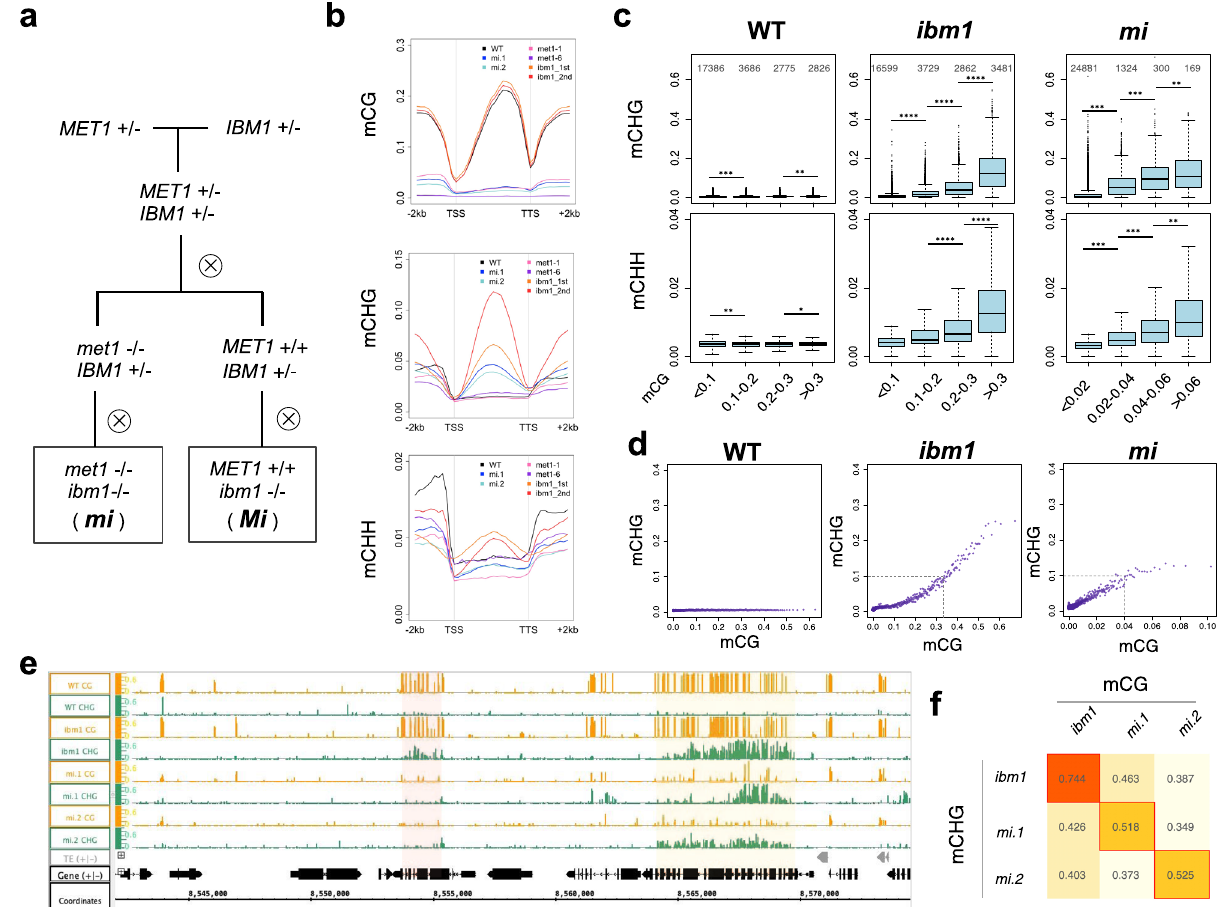
Fig. 3 Genic mCH is directed to regions with relatively high levels of mCG. a Materials used. Starting from the cross between plants having met1-1 ( met1 ) or ibm1-4 ( ibm1 ) mutation in the heterozygous state, the double heterozygote was self-pollinated to fi x met1 homozygote and MET1 wild-type in the F2 generation. The ibm1 mutation was fi xed to be homozygous in the F3 generation. The F3 plants with homozygous met1-1 mutation ( mi ) and homozygous wild-type MET1 ( Mi ) were used in this study. b Averaged mCG, mCHG, and mCHH pro fi les over genes in a WT plant, ibm1 , met1 ibm1 ( mi ), and met1 mutants. Values for met1 -6, a null mutant of MET1 , are shown for comparison (GSE148753). c mCH levels are correlated with the mCG levels in both ibm1 and mi . Genes are divided according to the mCG levels in the indicated genotypes and corresponding mCH levels are shown in boxplots (* P < 0.01, ** P < 0.001, *** P < 0.0001, Wilcoxon rank-sum test, two-sided). The number of genes in each class is shown on the top. The centerline and box edges represent quartiles and whiskers range 1.5 times of the interquartile from the box edges. d The genes were sorted by the mCG levels of indicated genotypes, grouped in bins with 50 genes, and averaged mCHG levels in the bins are plotted against averaged mCG levels in the corresponding bins. Mean value is plotted for each bin. e Browser view of mCG (orange) and mCHG (green) in WT, ibm1 , and two individual mi mutants. The region of Chr1/ 8,542,000 – 8,574,500 is shown. Gray and black arrows represent TEs and genes, respectively. The yellow shadow indicates an example of genic mCHG commonly seen in ibm1 and mi mutants. It has residual mCG in the mi plants. The pink shadow indicates an example of genic mCHG seen in ibm1 but not in mi mutants. f Correlation analysis of mCHG and mCG in the ibm1 and two mi individual plants. The best correlated in the individuals are boxed in red. The number in the box represents Pearson ’ s correlation coef fi cient. To exclude mis-annotated TEs, the genes with mCHG in the WT (>0.05) are excluded from the analysis in panels b – d and f (excluded n = 1562; analyzed n = 26,723). Source data underlying Fig. 3c, d are provided as a Source Data fi